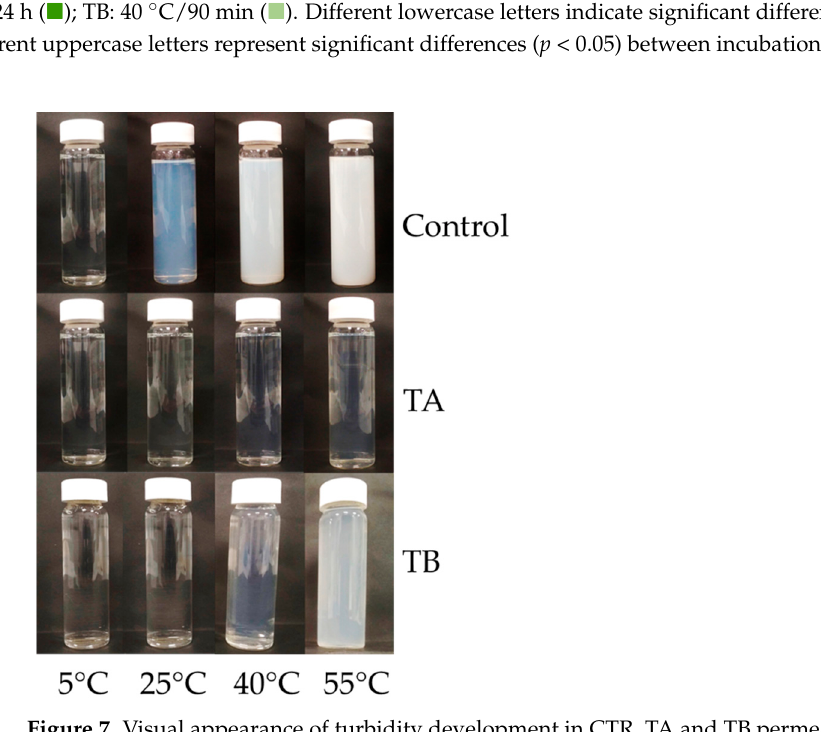
Figure 7. Visual appearance of turbidity development in CTR, TA and TB permeate samples